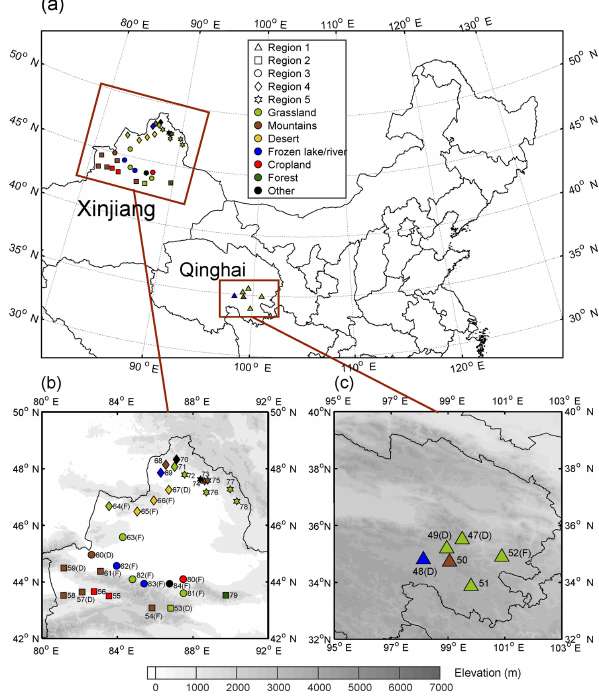
Figure 1. (a) Location of study area and sample site distribution across northwestern China. The site numbers and regional group- ings are shown in panel (b) for Xinjiang and (c) for Qinghai. Sample sites are divided into five groups indicated by different symbols, and the land cover types are represented in different colors, as shown in the legend in panel (a) . The D indicates that the sample was col- lected from a snow drift, and the F indicates that the sample was fresh snow. The elevation is shown in the contour plot.